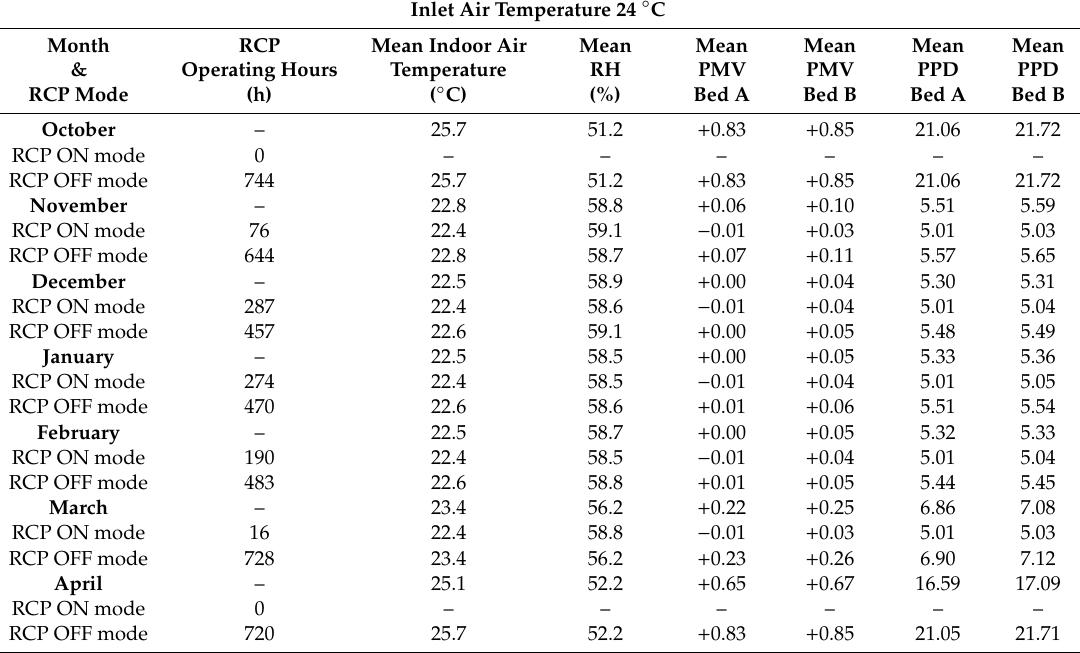
Table 9. Monthly RCP operating hours, mean indoor air temperature, RH, PMV and PPD with inlet air temperature of 24 ◦